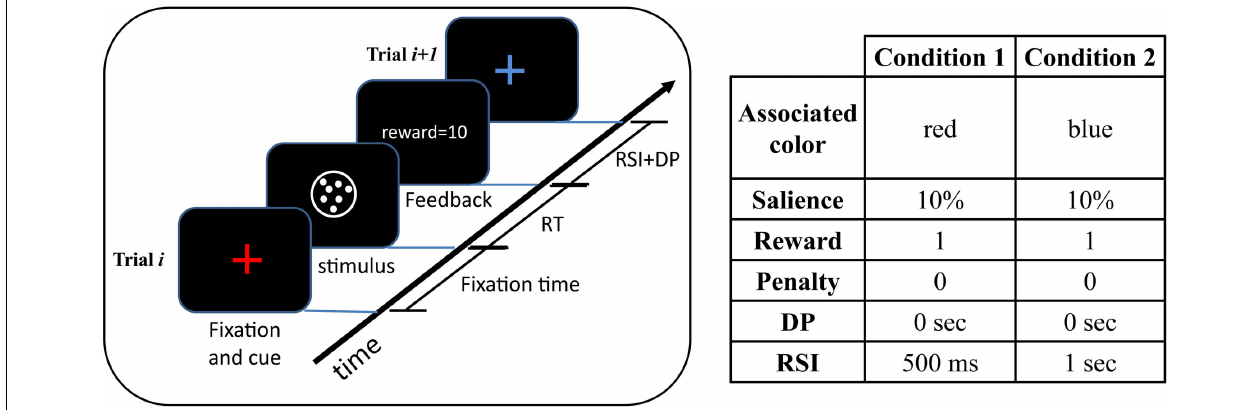
the next trial is determined by the delay penalty (DP) and response-stimulus interval (RSI). The table on the right of the figure shows the cue-condition association along with the task parameters in each condition. As seen, the two conditionsdifferonlyinthevalueoftheRSI.See Table 1 foradescriptionofthe task parameters. In this table, a separate parameter for the fixation time is not considered and instead it is considered as a part of the